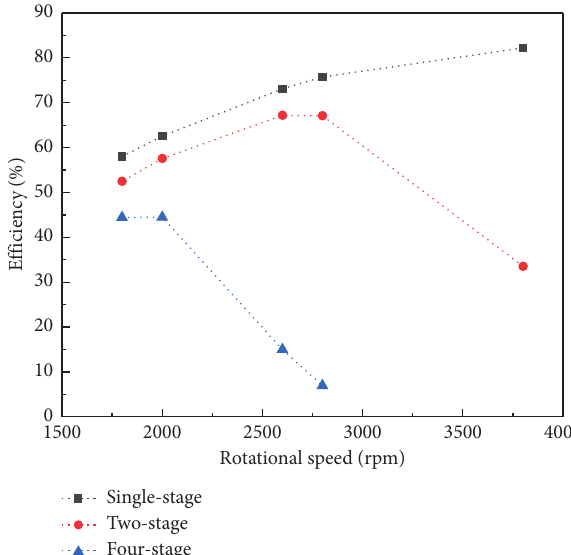
Figure 11: Relationship between output efficiency and rotational speed of large-size turbines.